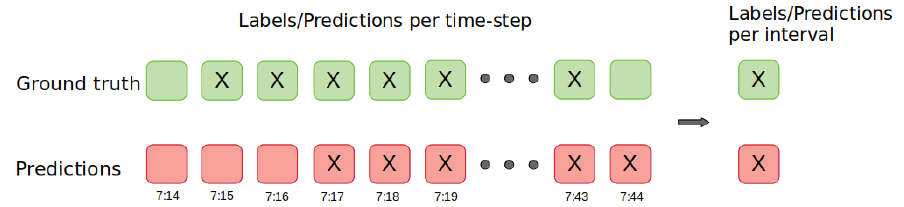
Figure 3. Example of the grouping process. ( Left ) Input sample with 30 time-steps. ( Right ) Equivalent interval grouped